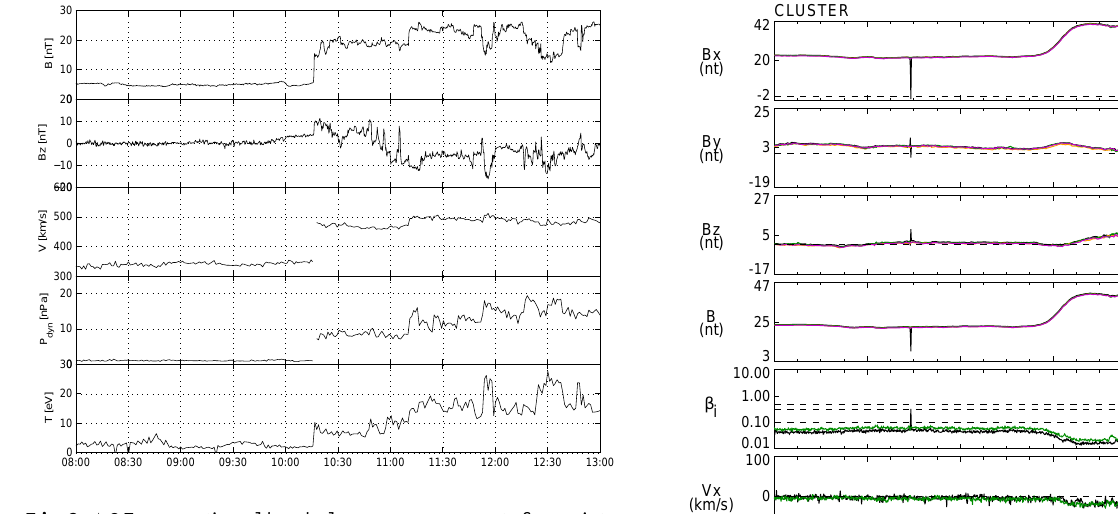
Fig. 2. ACE magnetic field and plasma measurements for an inter- planetary shock observed on 17 August 2001 at 10:16 UT. Panels show magnetic field intensity, the IMF Z component in GSM co- ordinate system, plasma speed, dynamic pressure and proton tem- perature. The shock was associated with a tail lobe SI observed by Cluster at 11:07 UT at a distance X =− 18 . 3 R E downtail.